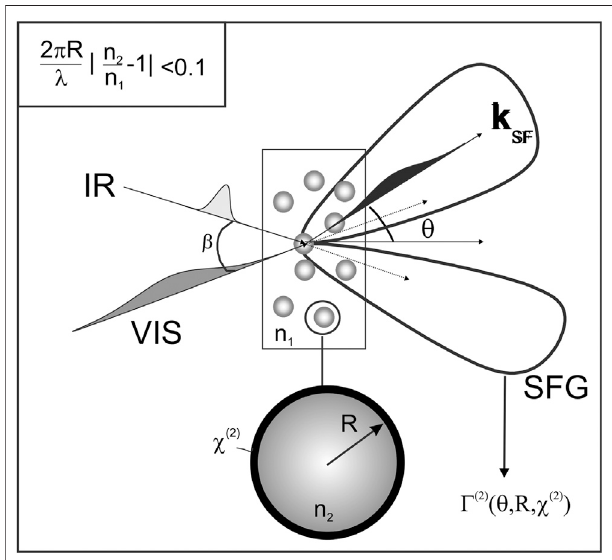
FIGURE 14 | Illustration of a second-order vibrational sum-frequency scattering experiment. The incoming beams generate a nonlinear optical polarization at the interface of a particle. The polarization is the source of the scattered sum frequency light. The magnitude (represented by the scattering lobes) and spectral shape of the scattered fi eld are determined by the molecular properties of the interface, which are contained in the second- order nonlinear susceptibility χ (2) . The angular distribution re fl ects both the value of the second-order susceptibility and the radius of the particle and the scattering geometry. The criterium used in the Rayleigh – Gans – Debye formalism is depicted in the upper left corner. n 1 and n 2 are corresponding refractive indices. The fi gure and caption have been adapted with permission from de Beer and Roke, (2007), Copyright © 2007 The American Physical